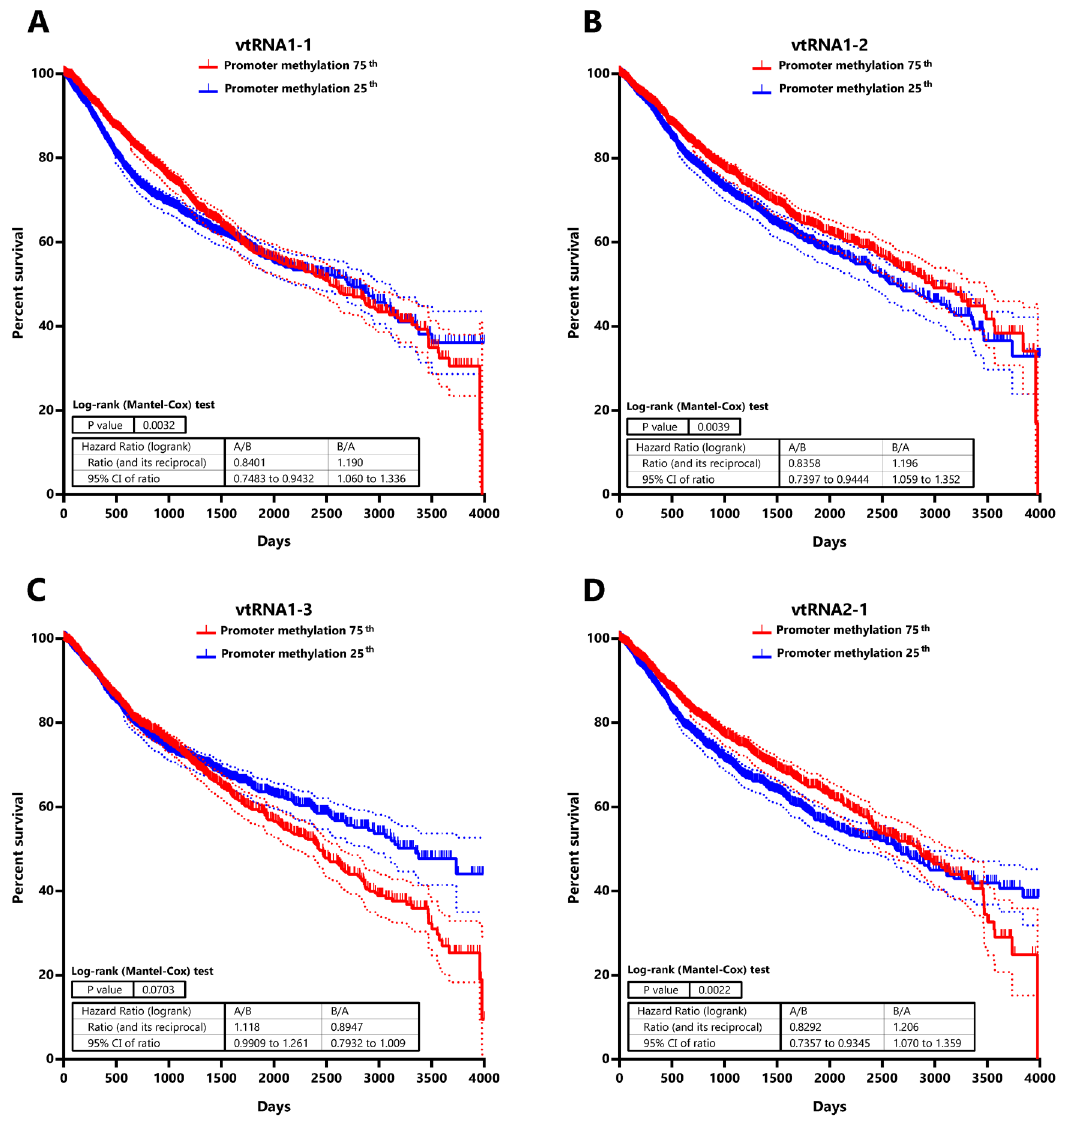
Figure 7. Association between patient Overall survival and vtRNA promoters DNA methylation status in Pan-Cancer TCGA dataset. Kaplan-Meier curves of overall patient survival probability over the time (4000 days) discriminating the primary tumors into two cohorts with relatively higher (75 th ) and lower (25 th ) DNA methylation at each vtRNA promoter. Promoter DNA methylation data of the 8060 primary tumors was used to stratify the patients in two quartiles, based on the expression of vtRNA1-1 ( A ) vtRNA1-2 ( B ), vtRNA1-3 ( C ) and vtRNA2-1 ( D ). Patient survival probability of the two groups was analyzed using Log-rank (Mantel-Cox) test. The dotted lines represent the 95% confidence interval for each